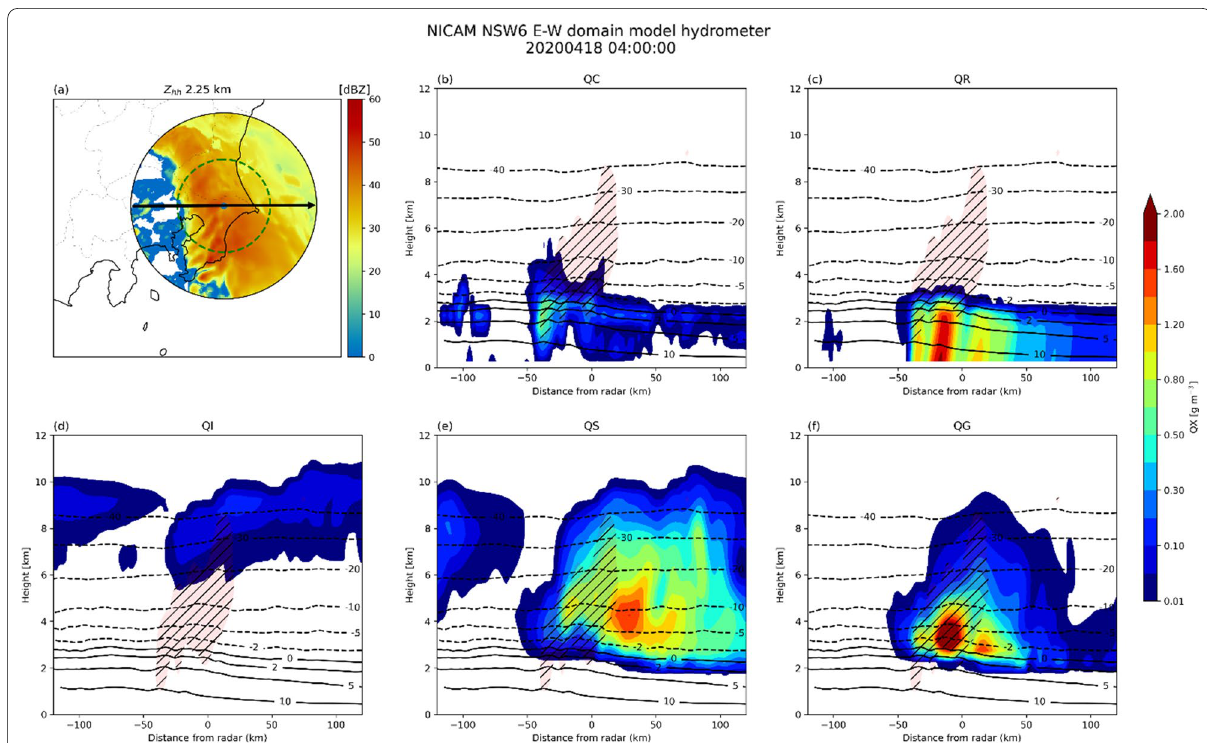
Fig. 10 a The same as Fig. 6a, showing the horizontal distribution of radar reflectivity (elevation angle 0.7°) for the NICAM-NSW6 simulation. Vertical cross sections of specific density of b cloud water, c rain, d cloud ice, e snow, and f graupel. The contours in the cross section show the temperature [°C]. The hatched area indicates vertical velocity stronger than 1 m s −